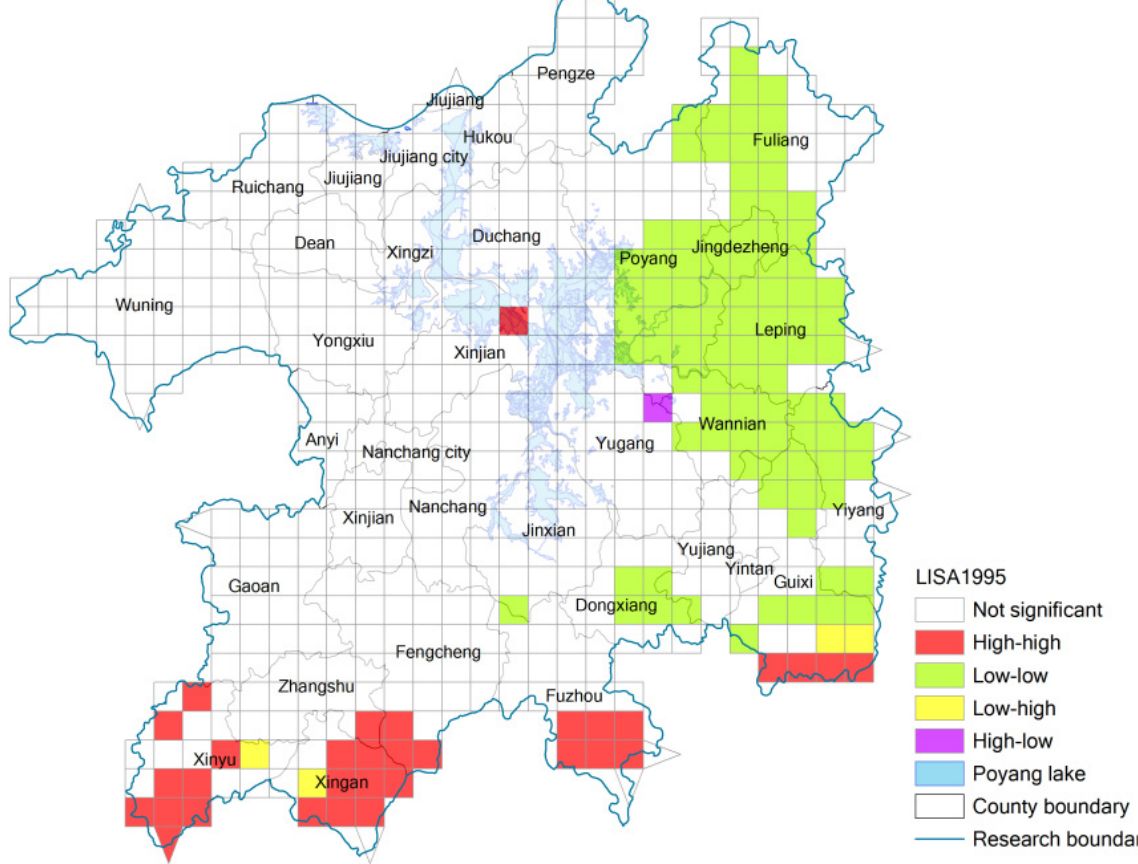
Figure 4. Locally spatial autocorrelation of eco-risk of the Poyang Lake Eco-economic Zone in